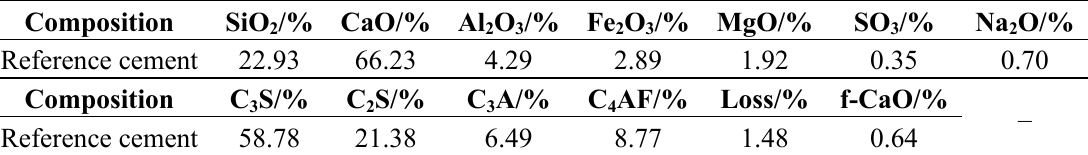
Table 1. Chemical and mineral compositions of the reference